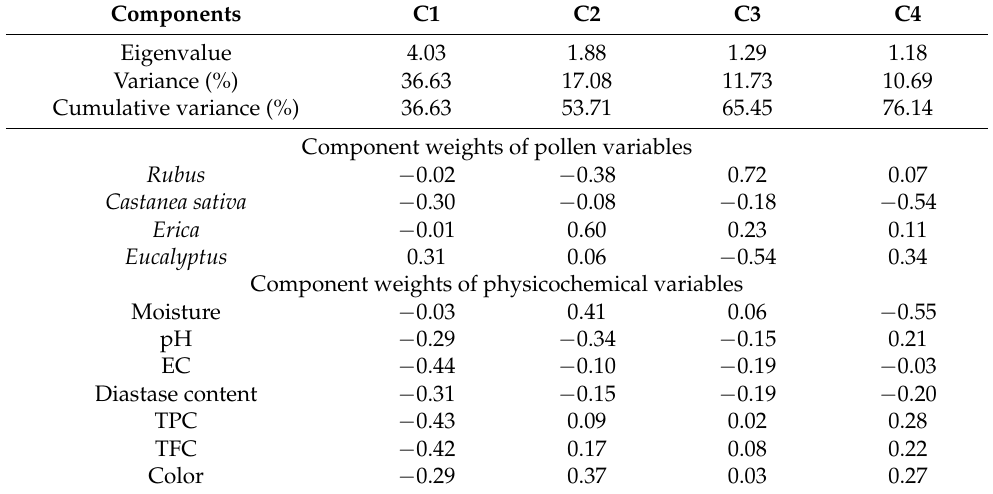
Table 3. Results of components extracted and weights of pollen and physicochemical variables by PCA. EC: electrical conductivity; TPC: total phenol content; TFC: total flavonoid